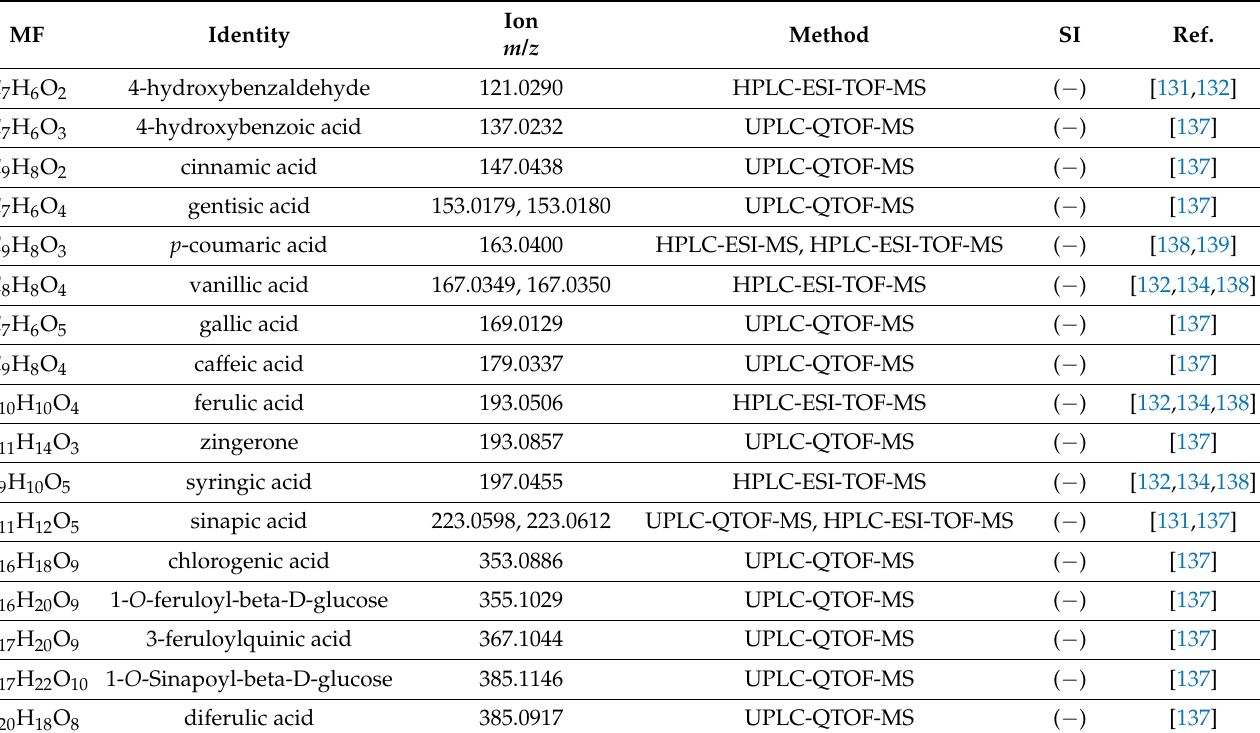
Table 3. Phenolic acids detected in wheat using LC and MS-based